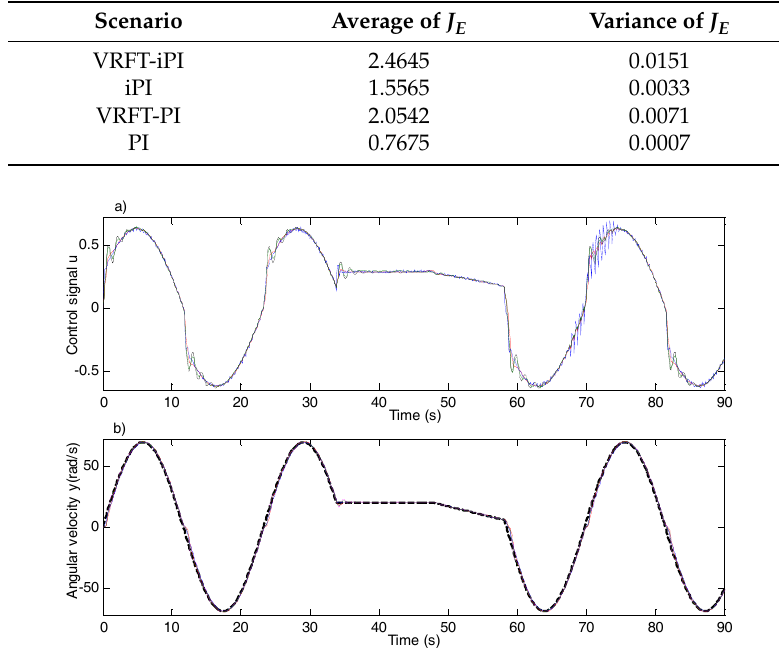
Figure 6. Experimental results of case study (2): control signal u of CS with VRFT-iPI (black), CS with iPI (red), CS with VRFT-PI (green), and CS with PI (blue) controllers in ( a ); reference trajectory y d (solid black dashed), controlled output y of CS with VRFT-iPI (black), CS with iPI (red), CS with VRFT-PI (green), and CS with PI (blue) controllers in ( b ).